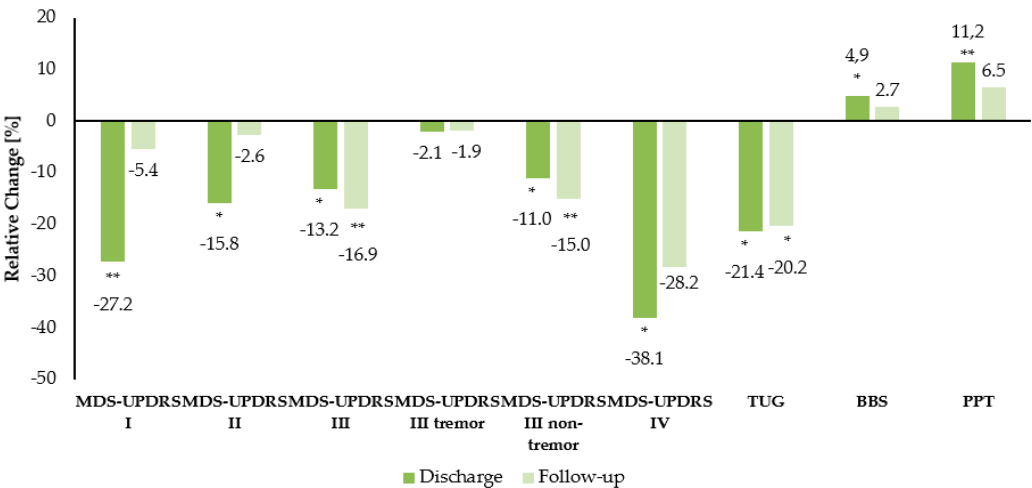
Figure 4. Relative change in distinct clinical outcome parameters from baseline to discharge (DC) and at a six-week follow-up (FU) illustrated as columns in %. Dark columns represent relative change at DC, light columns represent relative change at six-week FU. A p -value < 0.05 in post hoc analyses of repeated measures ANOVA is indicated by one asterisk (*), a p -value < 0.001 is indicated by two